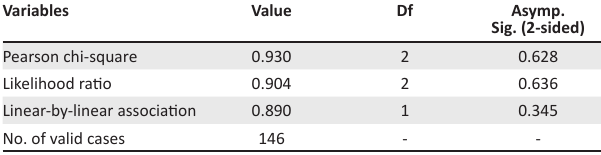
TABLE 2b: Financial assistance: chi-square